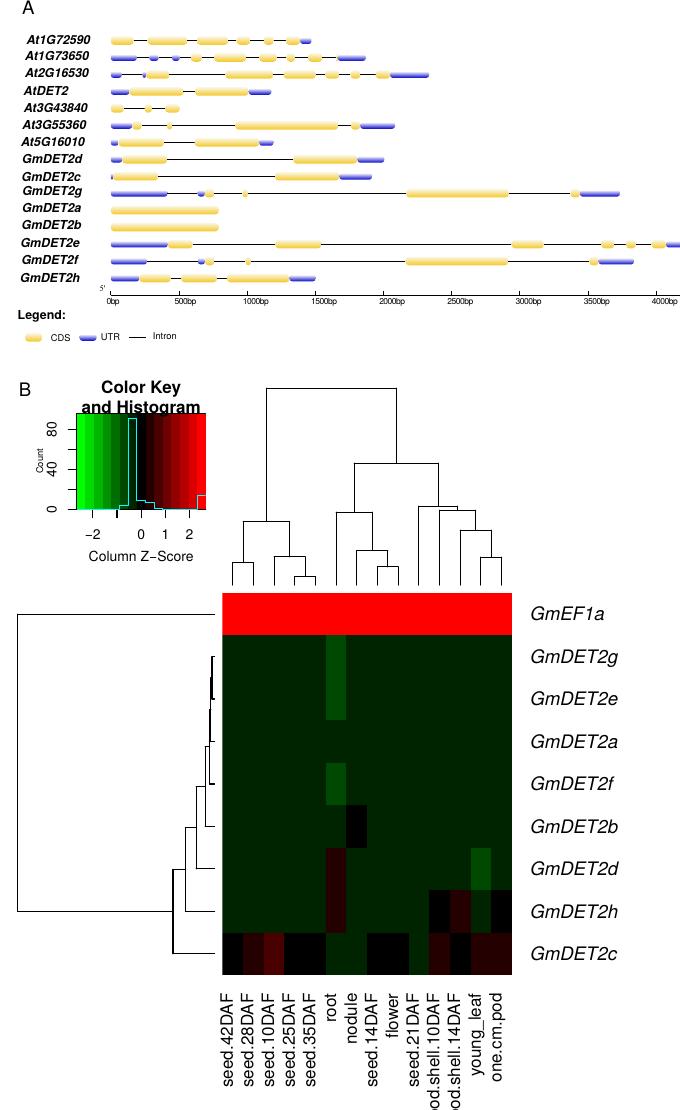
Figure 1. Gene structure of Arabidopsis and soybean steroid reductase and transcript levels of the soybean steroid reductase family. The gene structure of seven and eight steroid reductase from Arabidopsis and soybean are shown ( A ). CSDS2.0 was used to analyze the CDS (coding DNA sequence), UTR (untranslated region) and intron of these genes. The heat map ( B ) demonstrates the expression levels of GmDET2a to GmDET2h . The normalized expression data from RNA-Seq were downloaded from SoyBase [41]. DAF, day after